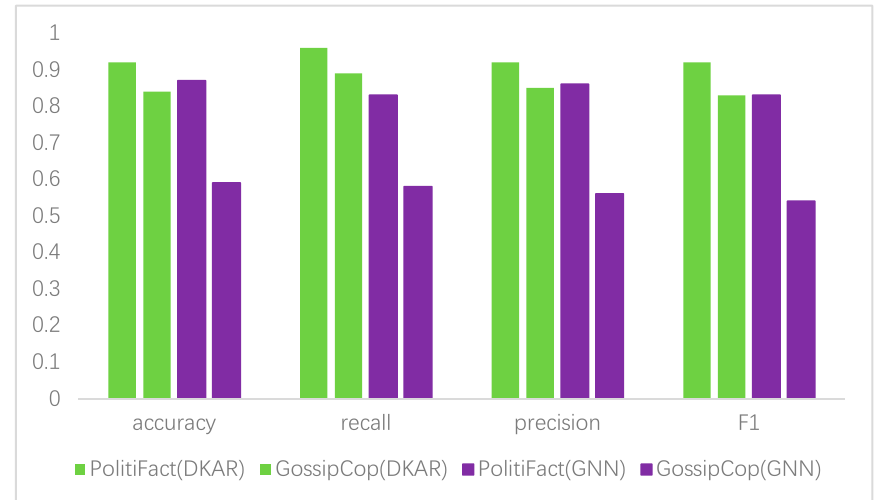
Figure 7. Models trained on the dataset of the PolitiFact perform comparably on the dataset of GossipCop, compared with the state-of-the-art model (GNN).